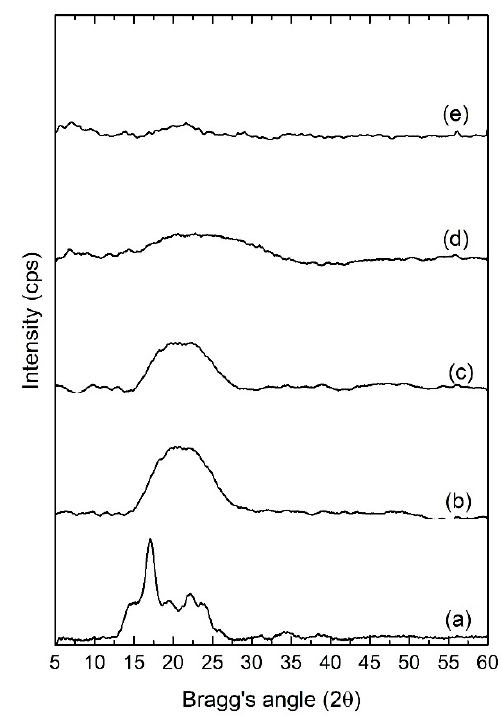
Figure 5. XRD diffractograms of ( a ) pure starch film, ( b ) SRF30, ( c ) SRF45, ( d ) SRF60-1, and ( e )